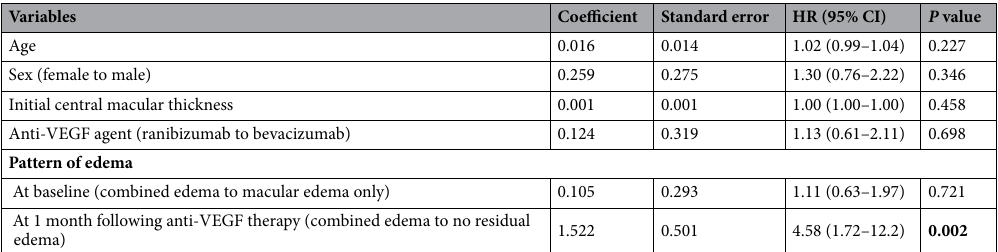
Table 3. Findings of a fitted proportional hazard model for macular edema recurrence. HR hazard ratio, CI confidence interval, VEGF vascular endothelial growth factor.